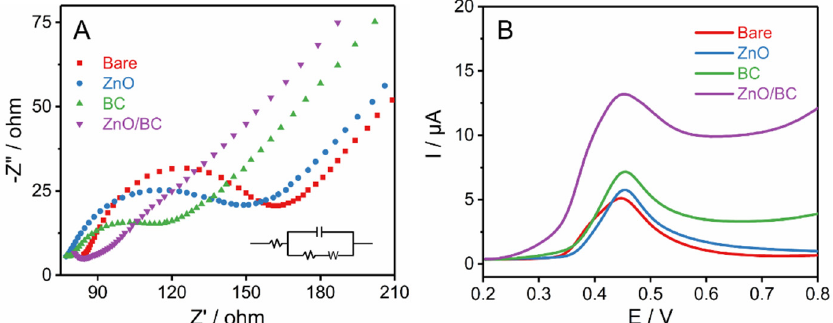
Figure 4. ( A ) EIS of modified electrode in 5 mM K 3 [Fe(CN)] 6 /K 4 Fe[(CN) 6 ] and 0.1 M KCl. ( B ) Comparison of DPV responses of modified electrode in PBS solution (50 mM, pH 7.0) containing 100 μ M BPA with a scan rate of 100 mV/s (accumulation time of 5 min).